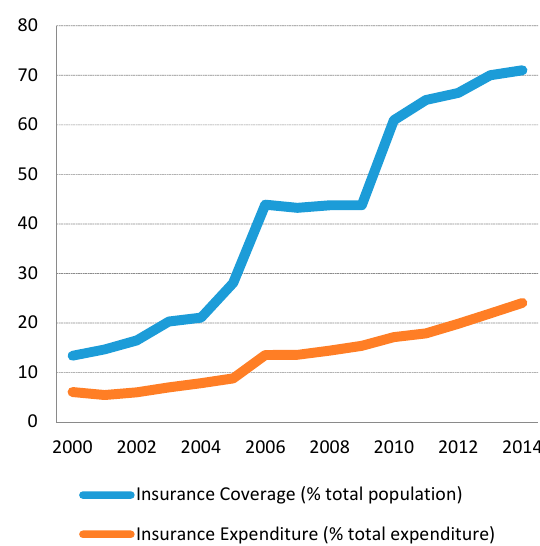
Figure 4. Insurance coverage and insurance expenditure.